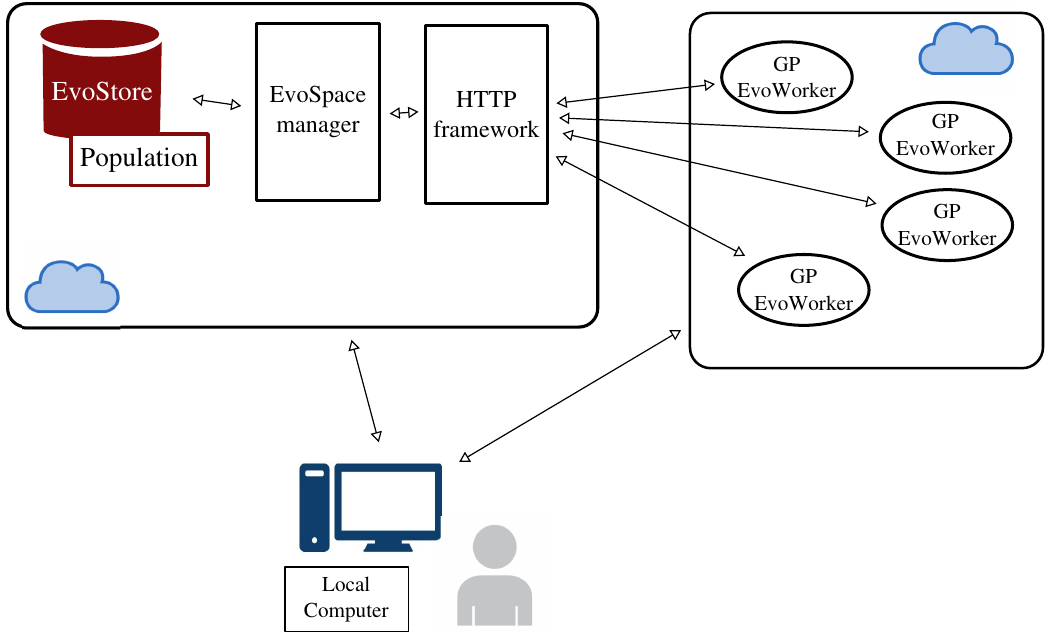
Figure 5. EvoSpace distributed